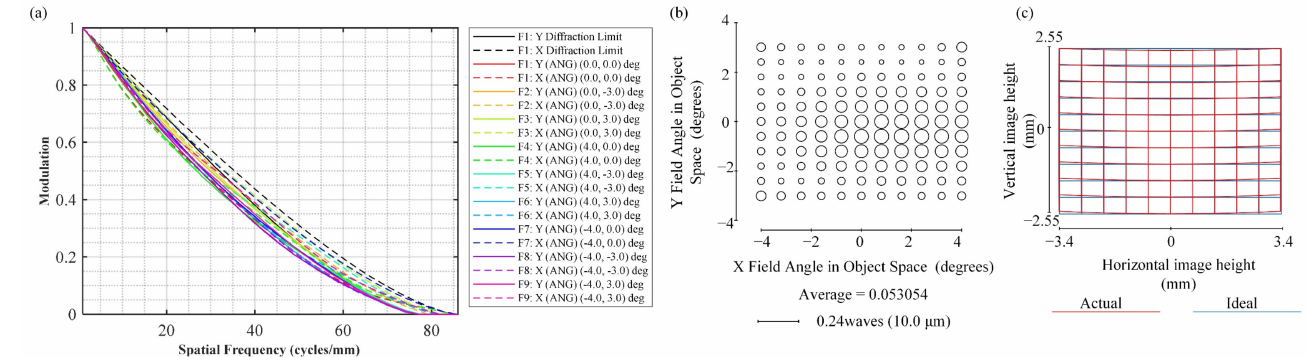
Figure 8. Performance of the final system: ( a ) the modulation transfer function, ( b ) RMS WFE, and ( c ) the distortion